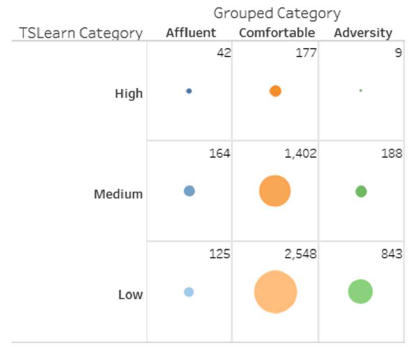
Figure 13. Energy consumption matrix for grouped categories vs. TSlearn categories.